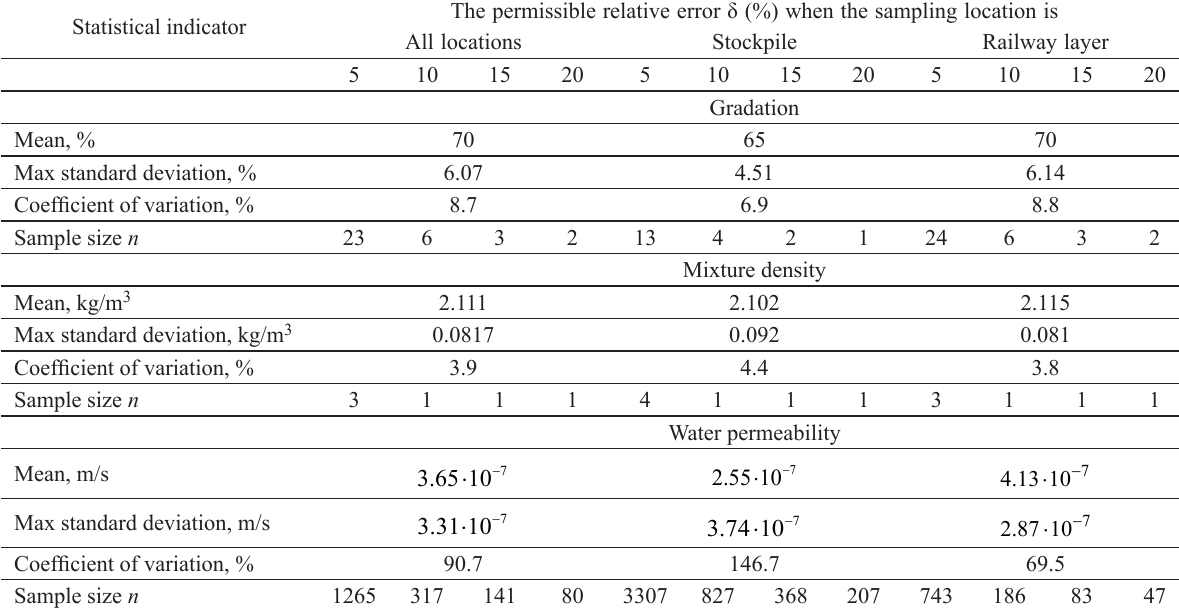
Table 6. Minimum number of samples for determining the KG1 mixture properties The permissible relative error δ (%) when the sampling location is Statistical indicator